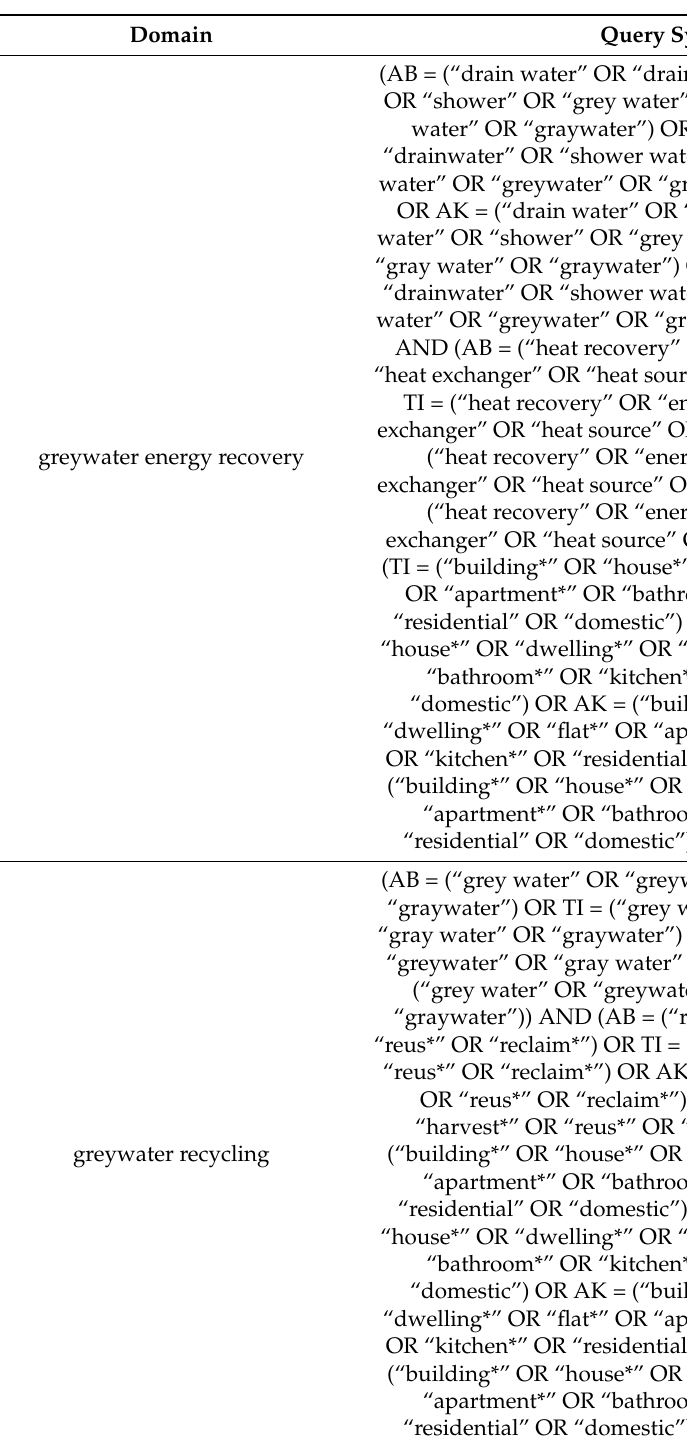
Table 3. Web of Science queries. The asterisk (*) was used to find both plural and singular forms of the